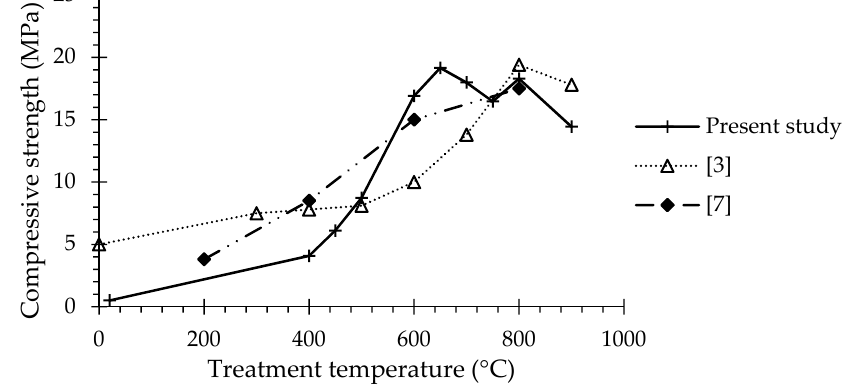
Figure 13. Compressive strength of RC pastes at 28 days compared with the results of other authors [4,8].